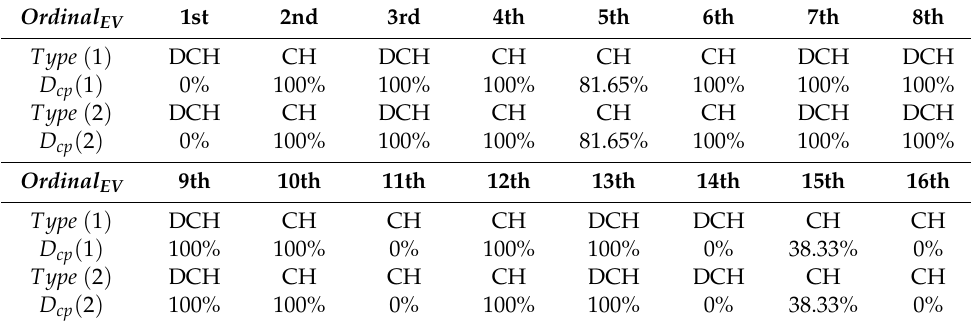
Table 5. Simulation results of ICDA and